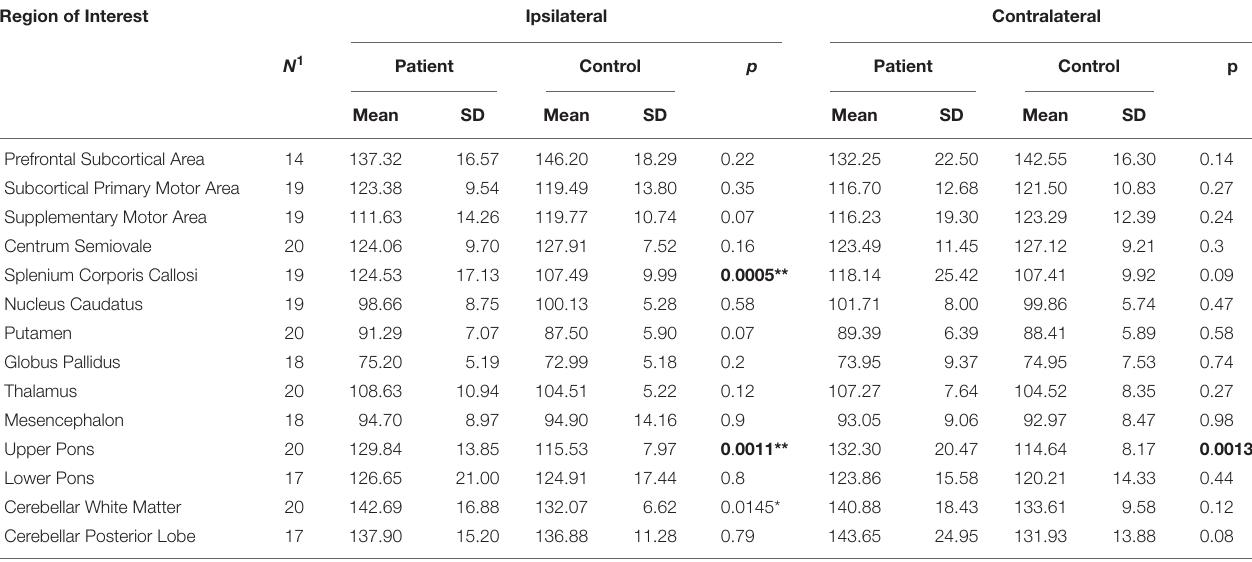
TABLE 4 | Paired t -tests between patients and controls for brain T2 relaxation times measured in brain hemisphere contralateral or ipsilateral to the more affected body side as indicated. Region of Interest Ipsilateral Contralateral